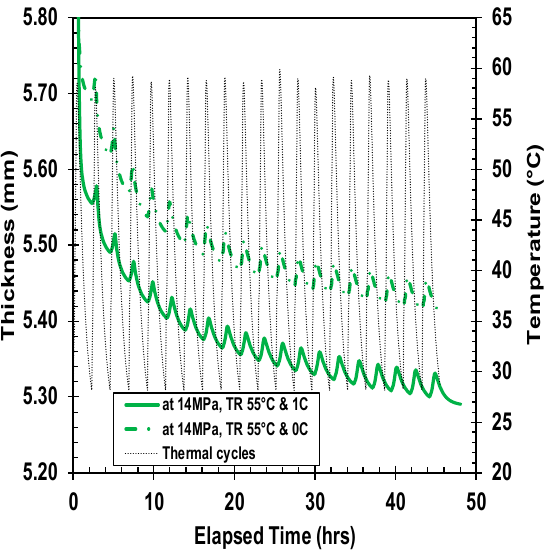
Figure 8. Ratcheting of HDPE with and without 1 day creep, at 14 MPa of stress.